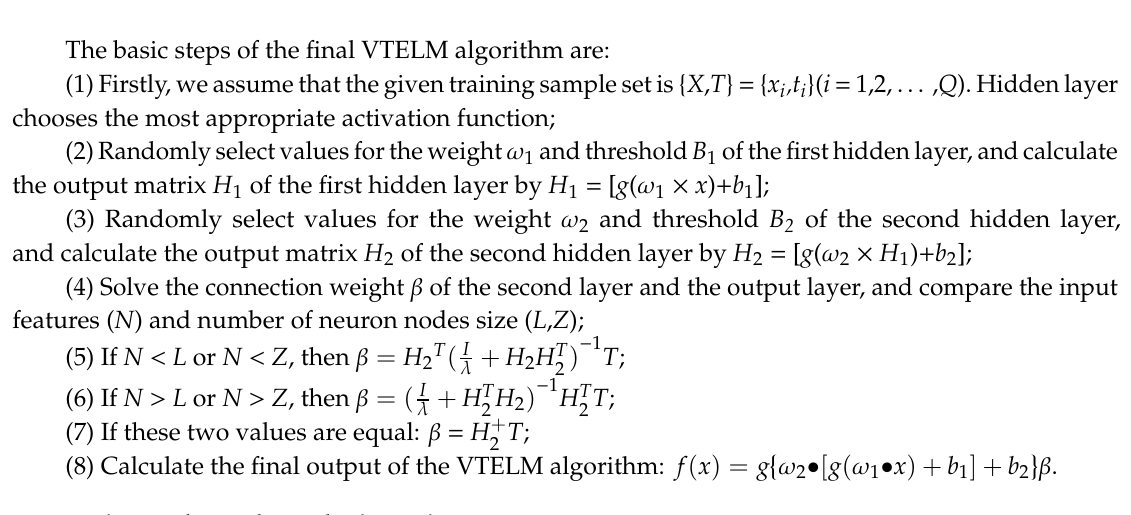
Figure 8. Spatial distribution map. 4.2. Neural Network Comparison First, this paper used ELM, BP, and RBF to establish inversion models of the copper content in copper ore. Because of the small number of samples collected, in order to maximize the use of 251 sets of data to test different models, our three models have adopted cross validation method for 10 times of copper ore cross validation. Table 2 shows the test results of the three models, and compares the models in terms of time consumption (s), root mean square error (RMSE) and coefficient of determination (R 2 ). Table 2. Copper content detection models based on different neural networks. Model Type